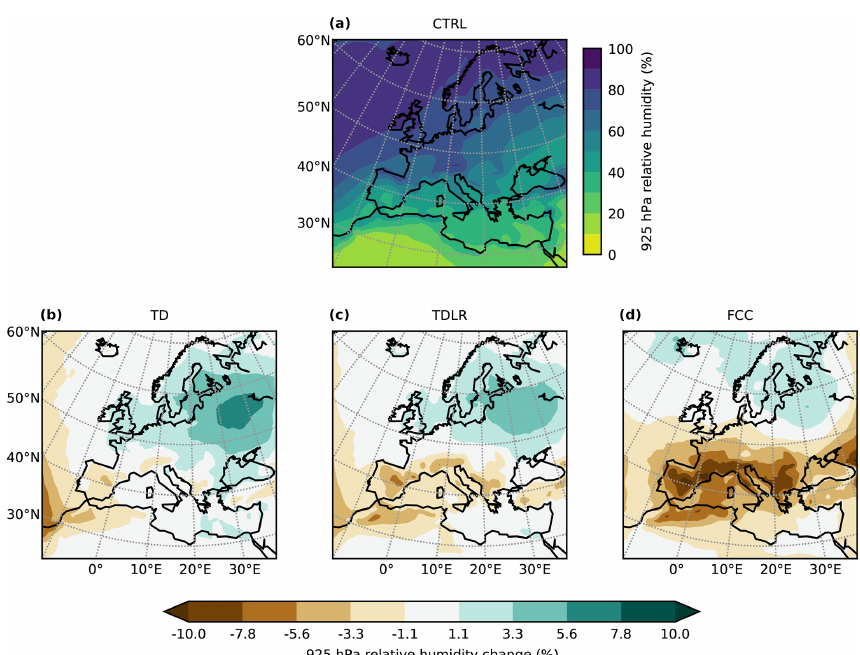
Figure 4. Mean summer relative humidity in the historical CTRL simulation and changes in the idealized simulations. (a) Climatological relative humidity in CTRL for the average summer in the 1971–2000 period. (b) Change in relative humidity in the idealized TD simulation, representing RCP8.5 and the 2070–2099 period. (c) Same as panel (b) but for TDLR. (d) Same as panel (b) but for the FCC, which is the GCM-driven transient regional climate